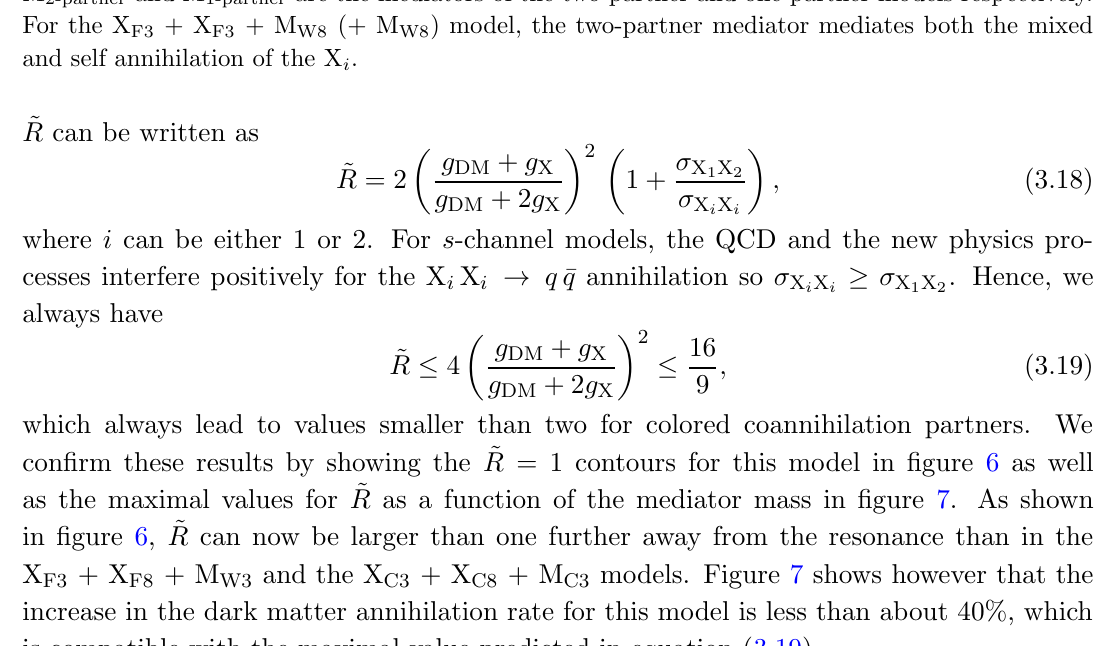
Figure 7 . Maximal value of ~ R for which all the mediators verify (cid:0) M < 1 m M . The particle content of each model is written as X 1 + X 2 + M 2-partner (+ M 1-partner ) where m X M 2-partner and M 1-partner are the mediators of the two-partner and one-partner models respectively. For the X F3 + X F3 + M W8 (+ M W8 ) model, the two-partner mediator mediates both the